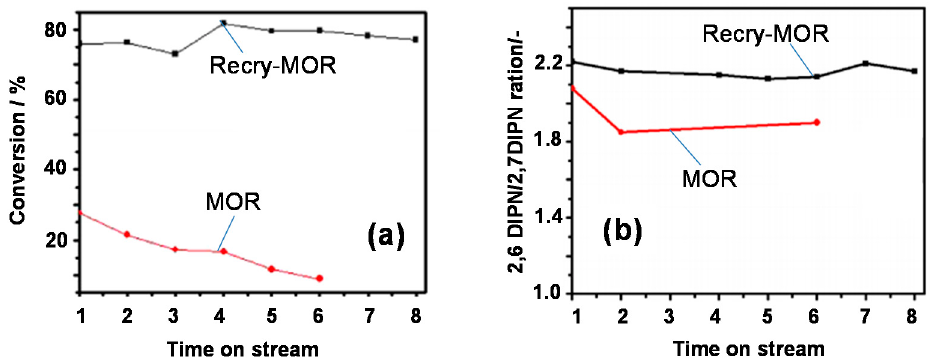
Figure 12. Catalytic performance of parent mordenite (MOR) and recrystallized MOR/MCM ‐ 41 composites (Recry ‐ MOR) in the alkylation of naphthalene with isopropyl alcohol: ( a ) conversion of naphthalene and ( b ) 2,6 ‐ diisopropylnaphthalene (DIPN)/2,7 ‐ DIPN ratio with time ‐ on ‐ stream [92].